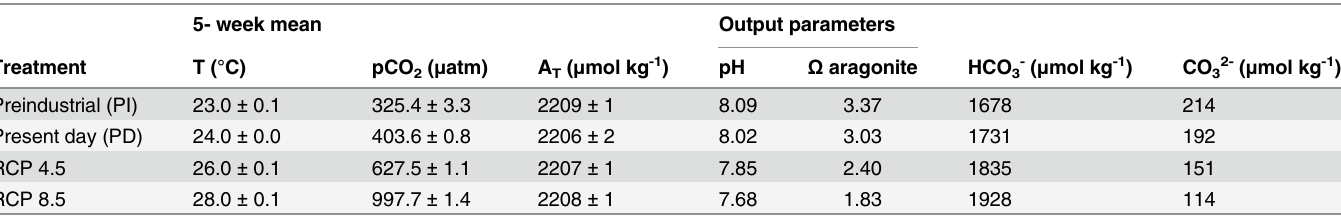
Table 1. Summary of mean seawater temperature and pCO 2 concentration. Seawater parameters were determined for the 5 week experimental period along with carbonate parameters estimated for experimental treatments, where RCP stands for Representative Concentration Pathway. The five week mean represents the mean of all the parameters over the course of the experiment. Total alkalinity (AT) is a mean of 8 seawater replicate samples per treatment (n = 8) collected weekly both at noon and midnight. Measured parameters are presented with ± standard error of the mean. Output parameters were esti- mated using the program